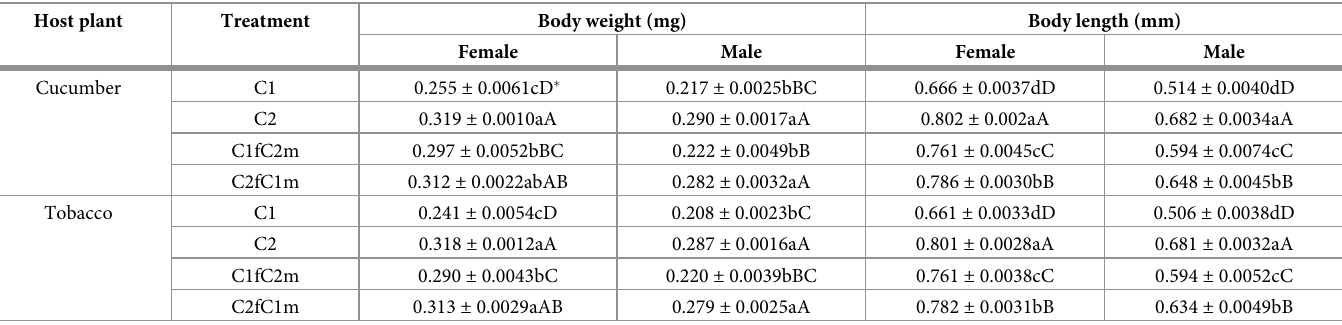
Table 6. Comparison of body weight and body length (mean ± S.E.) of B . tabaci .